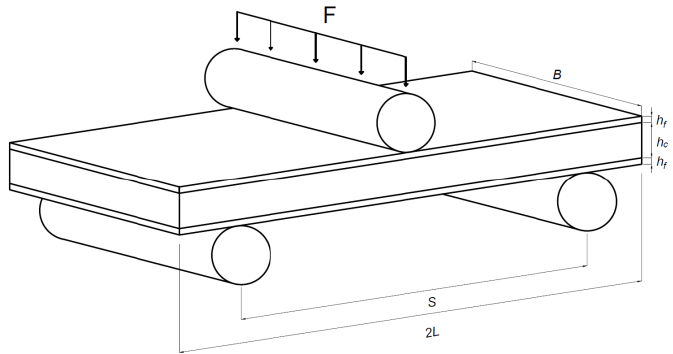
Figure 3. Three-point bending test configuration. Table 3. Three-point bending test specimen dimensions.